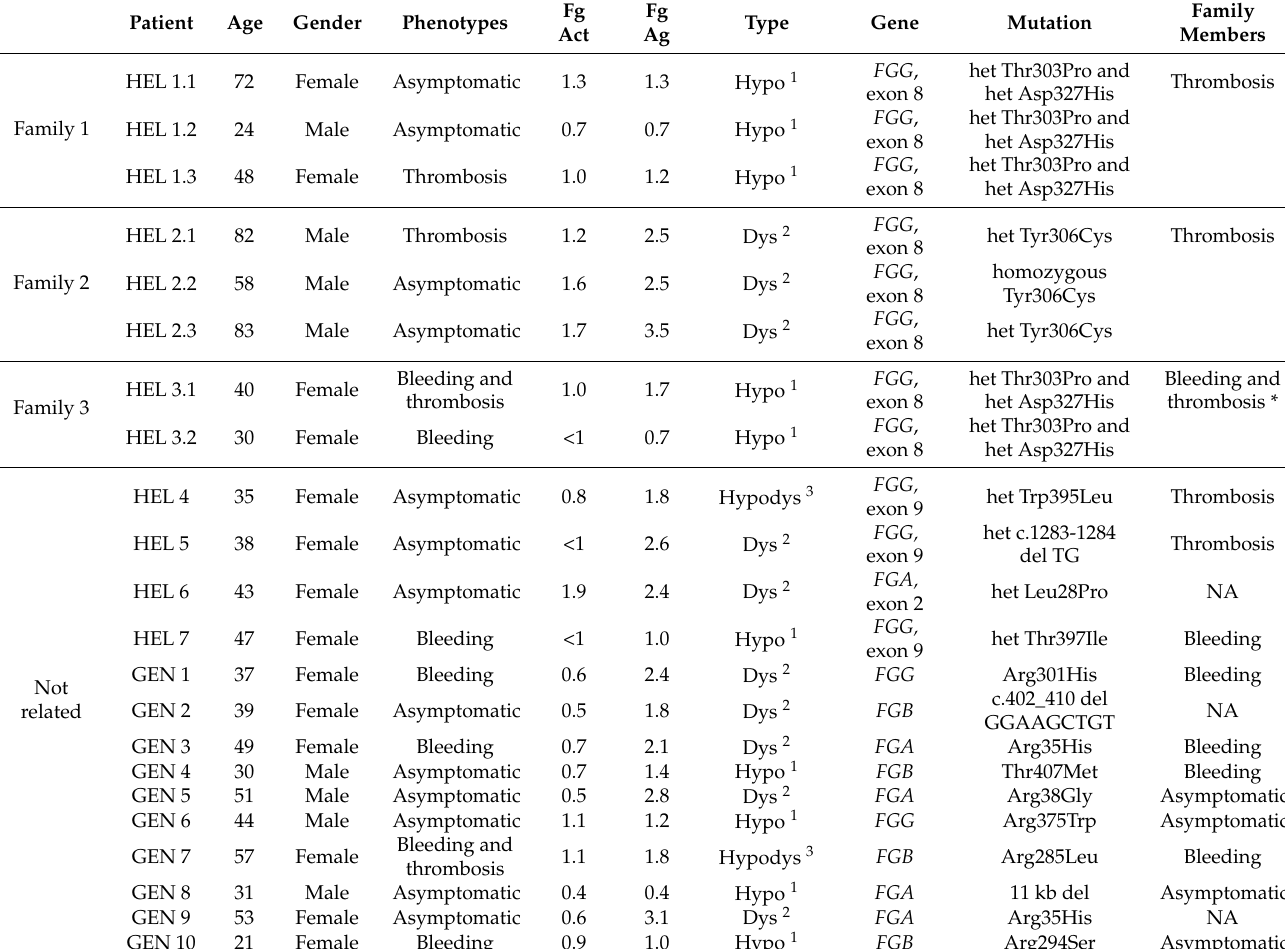
Table 1. Clinical manifestations, genotypes, and phenotypic characteristics according to traditional fibrinogen